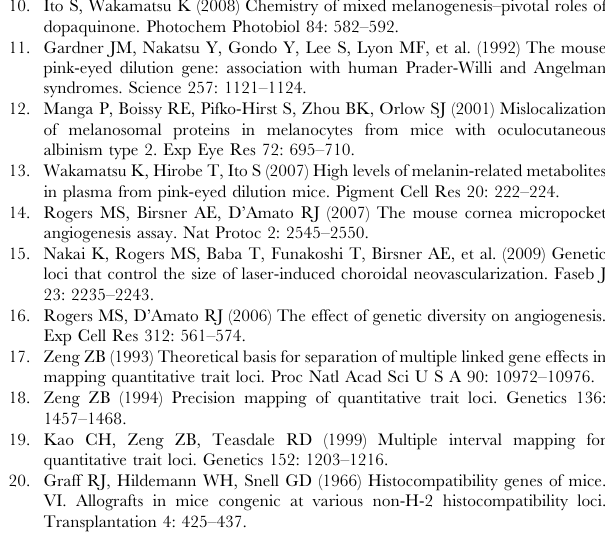
Figure S1 Composite interval mapping of the C57BL/ 6J 6 129P1/ReJ F2 cross. Whole genome composite interval map. Top: likelihood ratio statistic or likelihood of a region being linked to bFGF-induced corneal neovascularization. Bottom: predicted additive effect of a region on bFGF-induced corneal